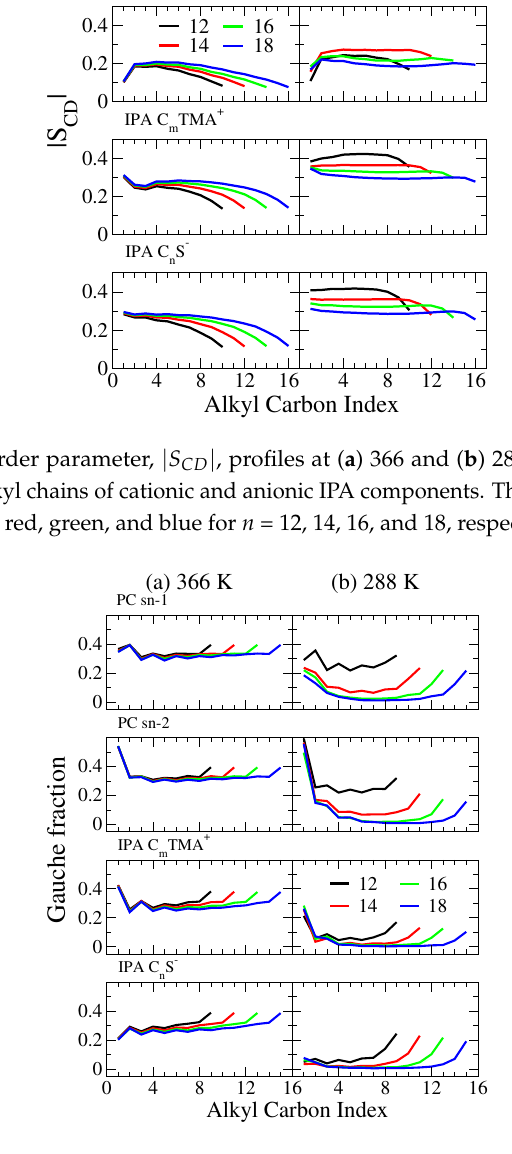
Figure 5. Gauche fraction profiles along the alkyl chains at ( a ) 366 and ( b ) 288 K for the sn-1 and sn-2 chains of PC and the alkyl chains of cationic and anionic IPA components. The color codes for the alkyl chain lengths are black, red, green, and blue for n = 12, 14, 16, and 18,